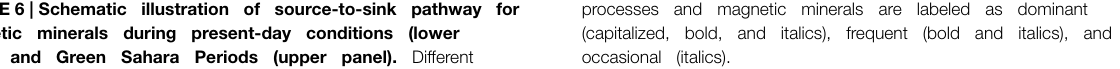
processes and magnetic minerals are labeled as dominant (capitalized, bold, and italics), frequent (bold and italics), and occasional